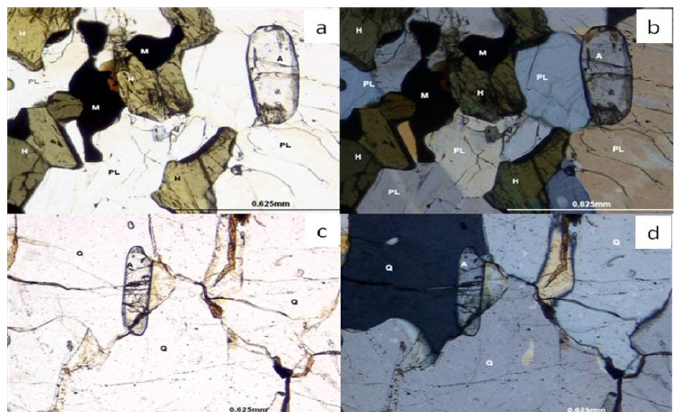
Figure 4: Photo micrographs showing apatite (A) in fresh (a; plane polarized light, b; cross polarized light) and weathered rocks (c; plane polarized light, d; cross polarized light) with less visible